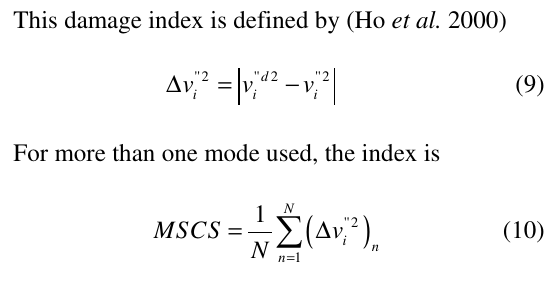
L = 1250 mm, width B = 50 mm and thickness H = 5 mm. Mill-cut damage with depth of 2 mm and size of 50 mm is introduced at a distance of 750 mm from one edge of the beam. The Beam 2 dimensions are 1500 x 50 x 5 mm. Damage with depth of 2 mm and size of 100 mm is introduced at a distance of 950